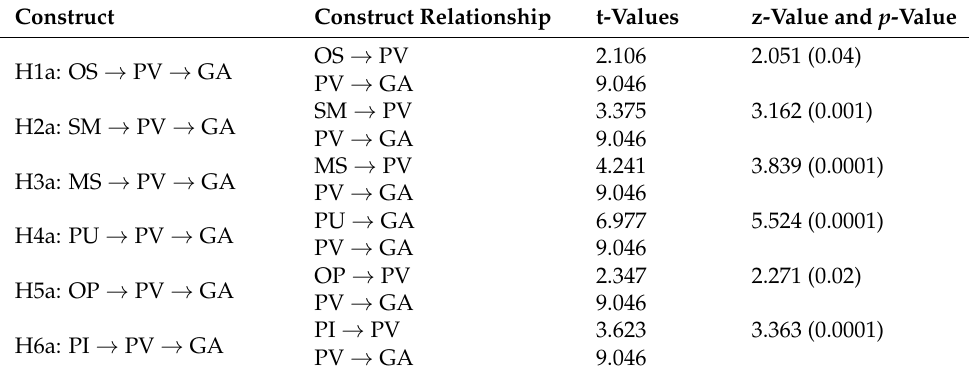
Table 7. Mediation test